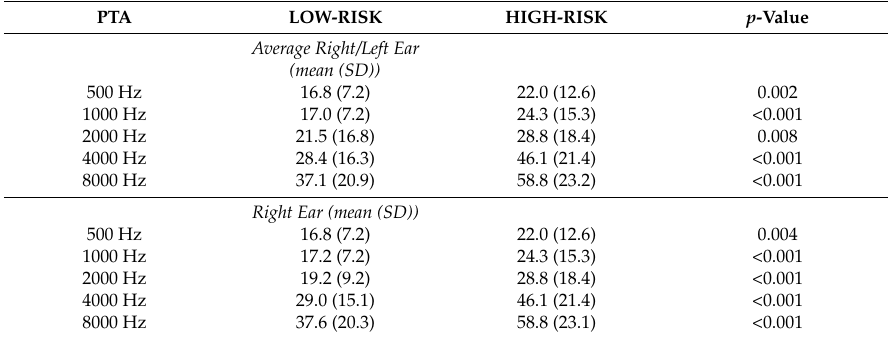
Table 2. Pure tone audiometry (PTA) analysis in the LOW-RISK and HIGH-RISK groups. Significant differences between groups were found for all frequencies for average, right and left ear thresholds.